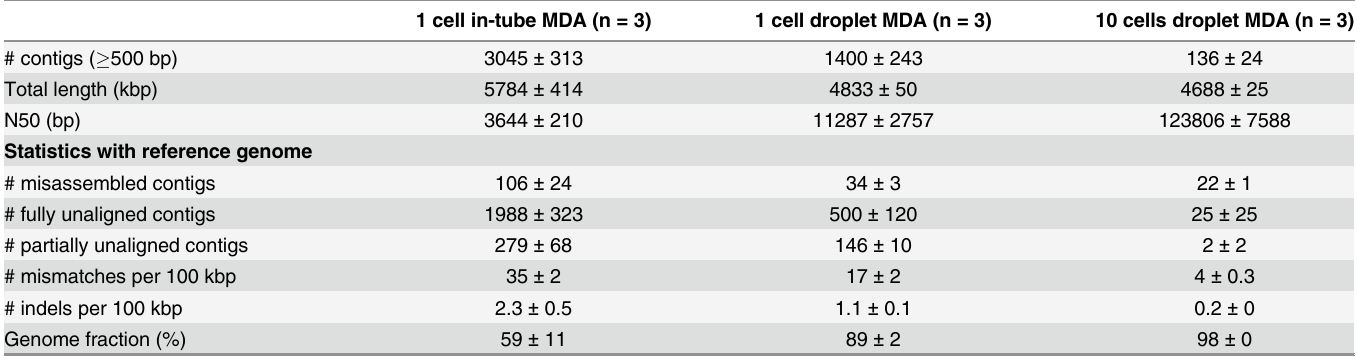
Table 2. Assembly statistics of MDA products obtained from single Escherichia coli cells. 1 cell in-tube MDA (n = 3) 1 cell droplet MDA (n =